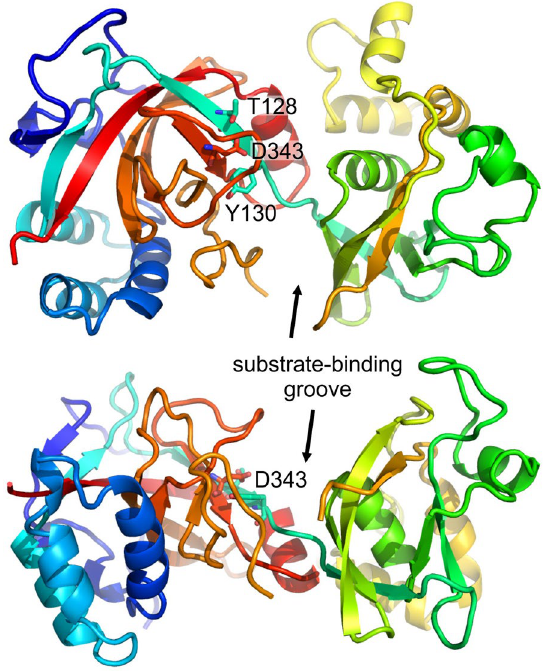
Figure 6. Crystal structure of LtgG at 1.7 Å resolution. Top and side views of LtgG showing the likely substrate binding groove and the essential aspartate residue, D343. Conserved residues proposed to form part of the catalytic site in the E . coli protein, MltA, are indicated.